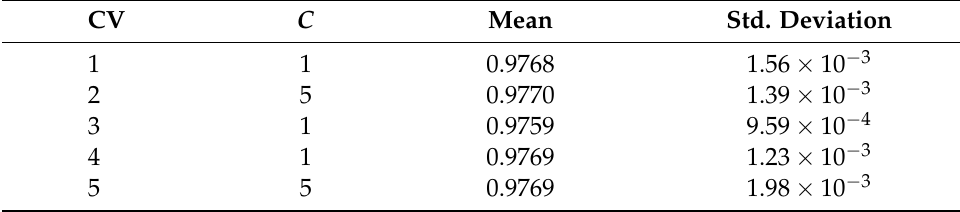
Figure 6. Support Vector Machine mean scoring by iteration. Table 5. Best SVM model by